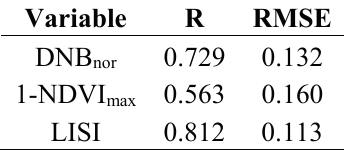
Figure 7. A comparison of the ISA distributions from three datasets for three cities, highlighting the better spatial patterns from the LISI-based model than the other two results; ( a1 – a3 ) represent ISA distribution using the DNB nor in Beijing, Wuhan, and Urumqi; (b1 – b3 ) represent ISA distribution using 1-NDVI max in Beijing, Wuhan, and Urumqi; and ( c1 – c3 ) represent ISA distribution using LISI in Beijing, Wuhan, and Urumqi. Table 3. A comparison of overall accuracy assessments among three